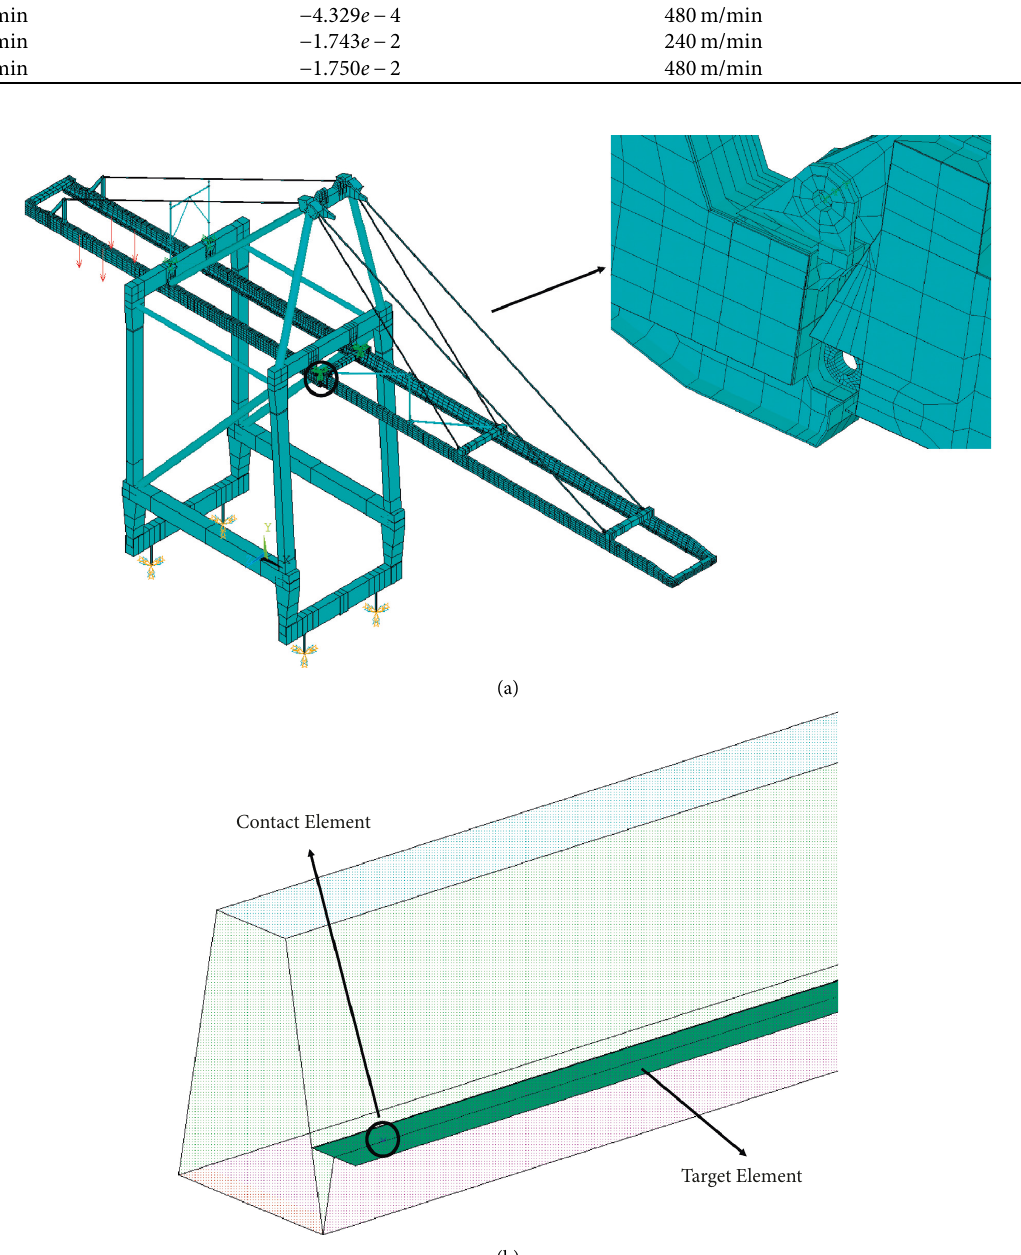
Figure 10: Refined model of the quay crane: (a) overall structure and (b) rail girder with target element on rail flange and contact element on mass